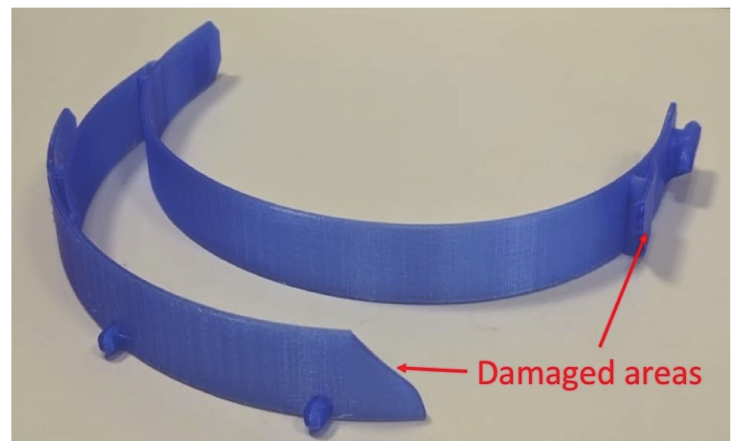
Figure 7. Part broken while being separated from the